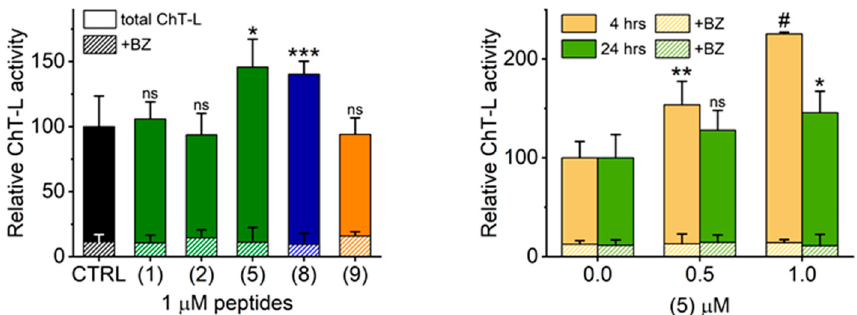
Figure 5. Treatment of human neuroblastoma SK-N-SH (ATCC HTB-11) cell line with selected TAT1 derivatives resulted in significant augmentation of the proteasome activity. Left: After 24 h treatment with vehicle (DMSO) or TAT compound, cell lysates were prepared and ChT-L activity measured. Relative activity per mg of protein in lysates is presented. Treatment of the same cell lysates with 1 µ M Bortezomib lead to almost complete abrogation of ChT-L activity independent of the type of TAT peptide used. Proliferation and viability of cells were not affected by the treatments: live cell counts remained at the level of 95%–107% of control, with the sole exception of a lower count for (9) (86%, non-significant difference). The content of dead cells varied between 9% and 12% for all samples (no significant differences). Right: SK-N-SH cells were treated for four or 24 h with 0.5 or 1.0 μ M of (5) and processed as above. An increase of proteasome activity was dose dependent and was affected by the treatment interval. Exposure of the cell lysates to 1 μ M BZ almost completely eliminated ChT-L activity and its dependence on treatment time and the applied (5) dose. The control 100% activity corresponded to 1.1 (24 h treatments) or 0.31 (4 h treatments) nanomol of the AMC product released by mg of the lysate per minute. *, p ≤ 0.05; **, p < 0.01; ***, p < 0.001; #, p < 0.00001 (t test; n = 3–4); ns - not significant difference.